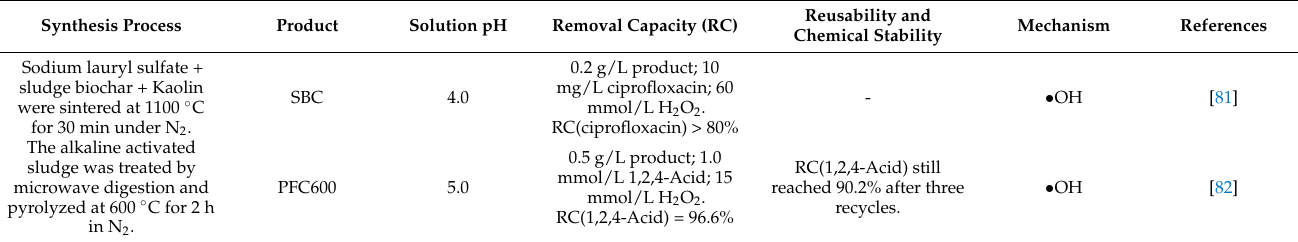
Table 3. Application of sludge-based catalysts in Fenton-like